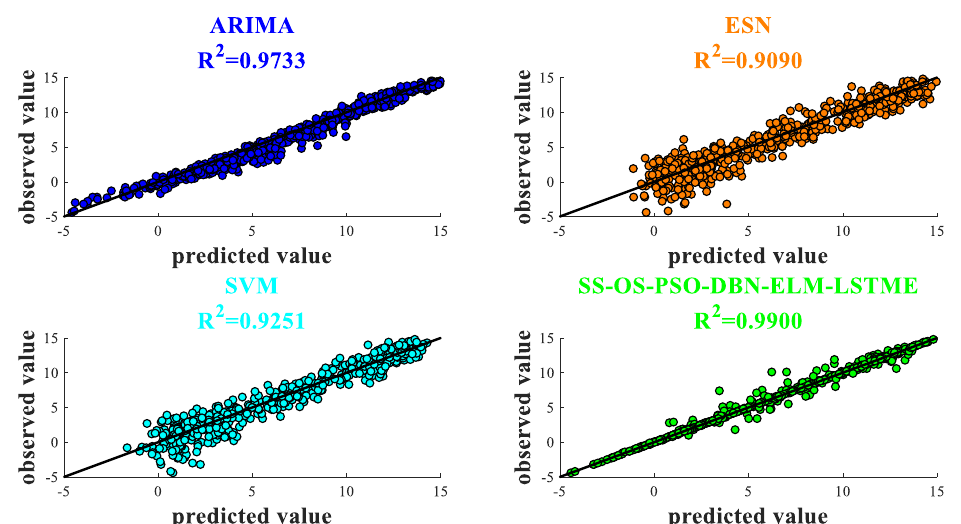
Figure 17. Scatter plots of the observed and predicted lowest temperature (unit: °C) using M6 − M9 models.